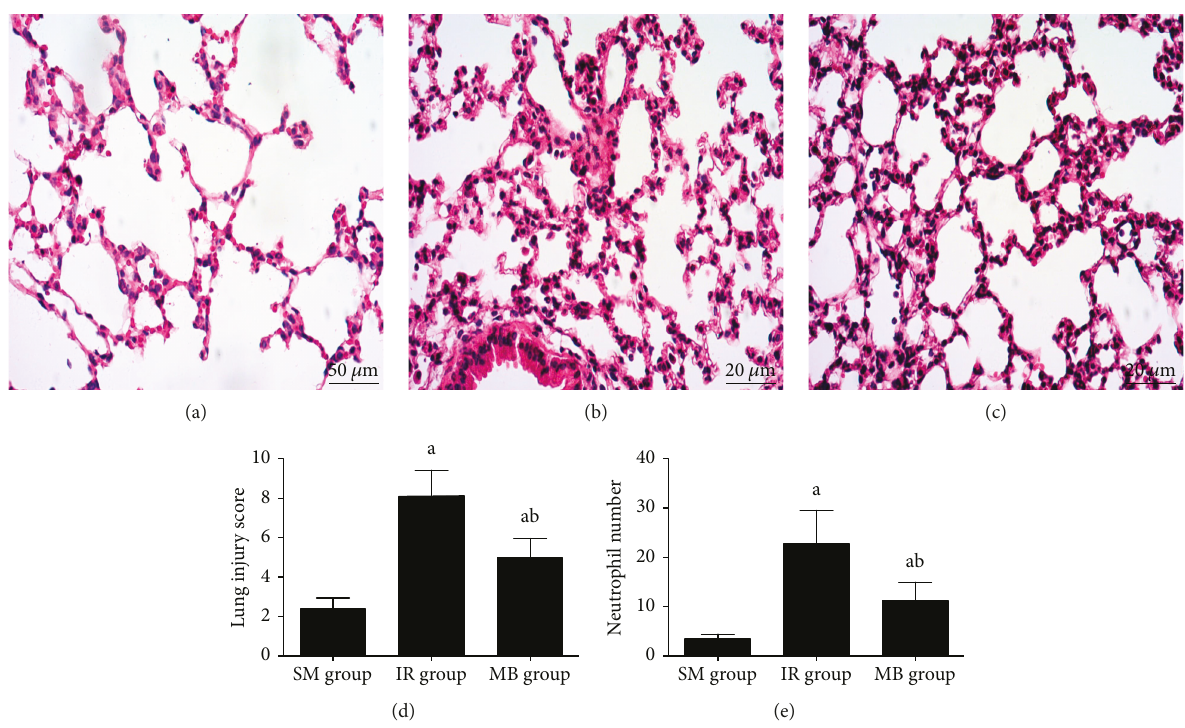
Figure 2: Histological changes in lung tissue. (a) SM group; (b) IR group; (c) MB group; (d) lung injury score; (e) neutrophil number. a p < 0 05 versus SM group; b p < 0 05 versus IR